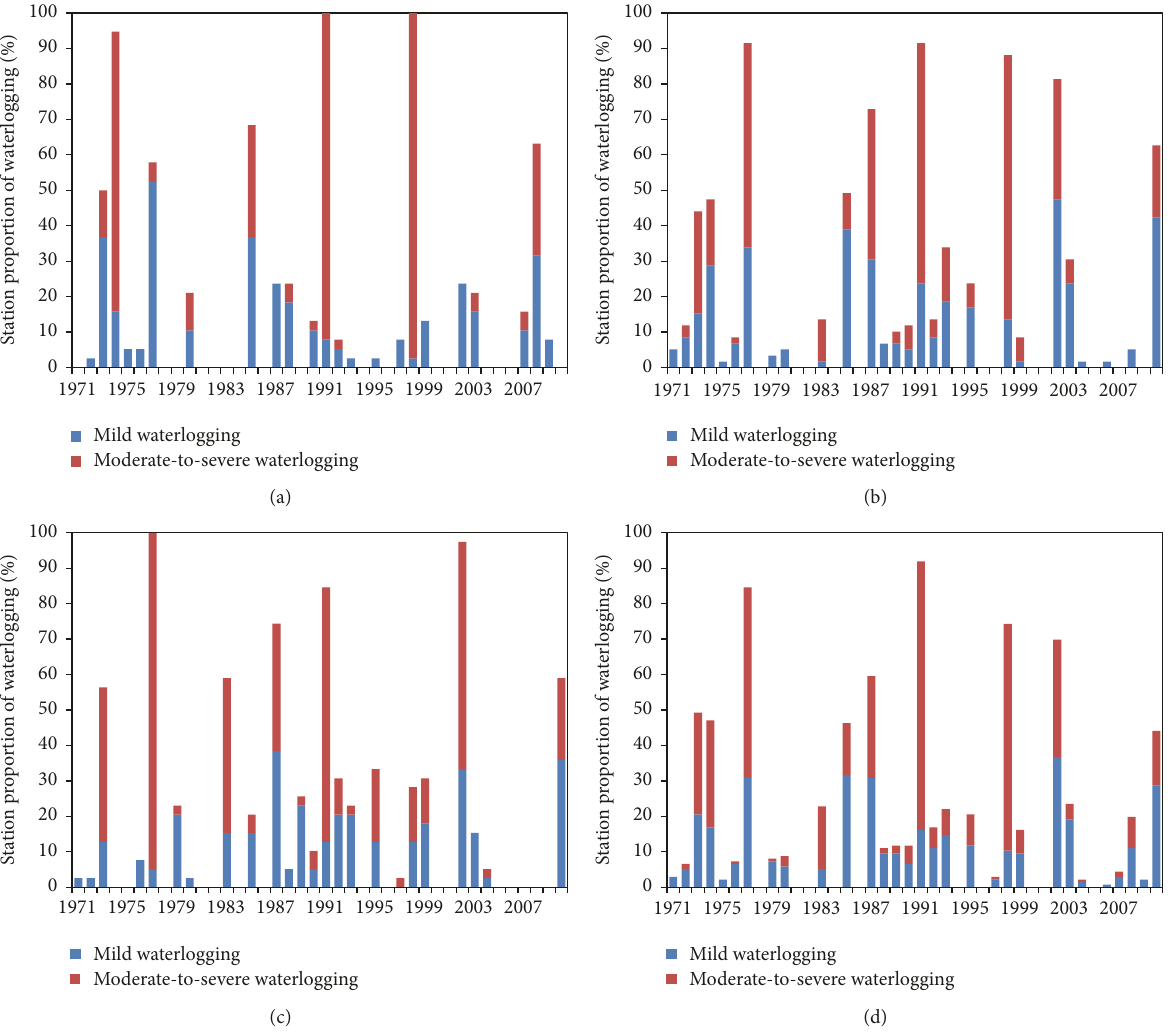
Figure 7: Proportion of winter wheat waterlogging in spring at meteorological station level for regions (a) R1, (b) R2, (c) R3, and (d) the whole region (R) during 1971 to